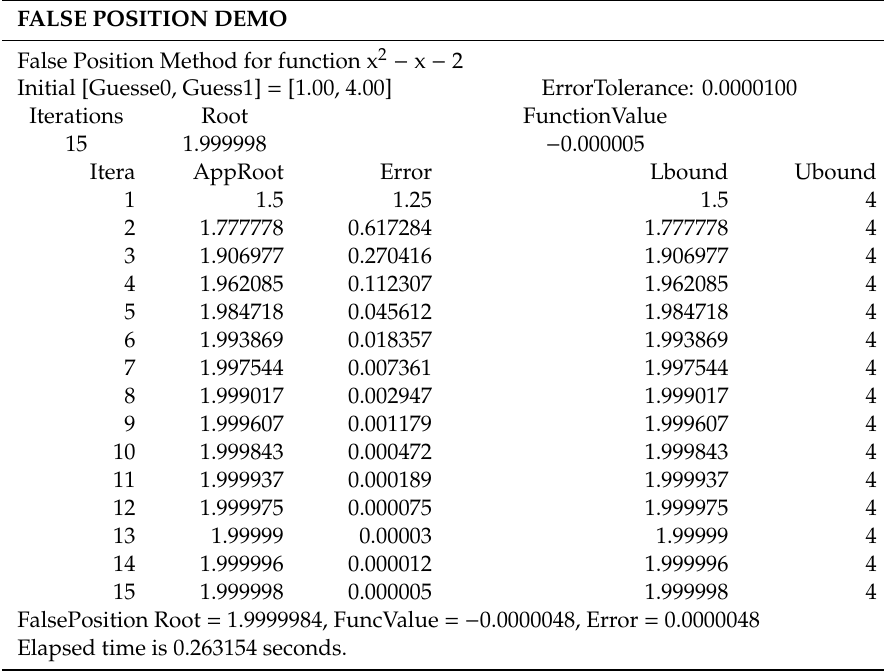
Table 5. False position algorithm, iterations, AppRoot, error and interval bounds.